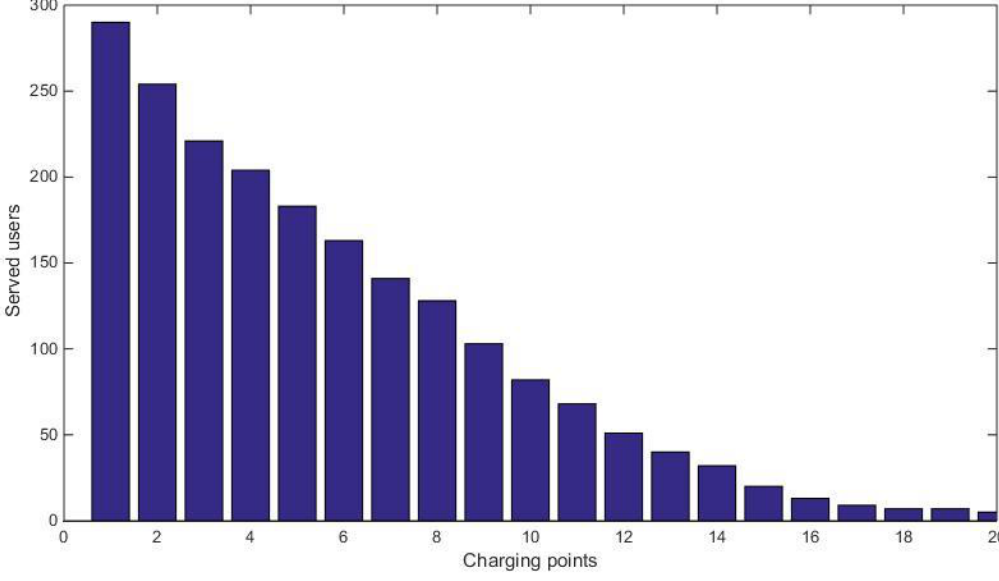
Figure 14. Distribution among CPs of served users at station #3 in scenario (0, 12, 20).